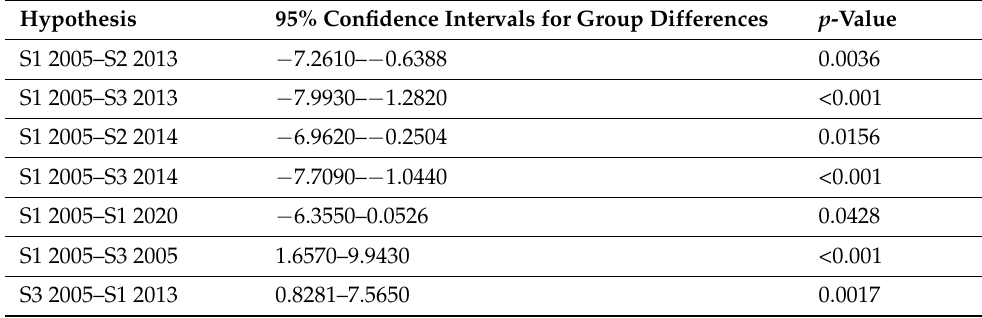
Table 2. Statistically significant differences from ANOVA analysis for seed primordia data. p < 0.05.